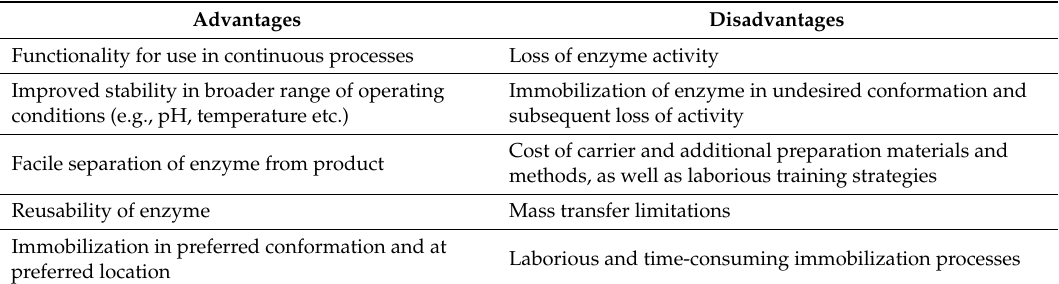
Table 2. Advantages and disadvantages of enzyme